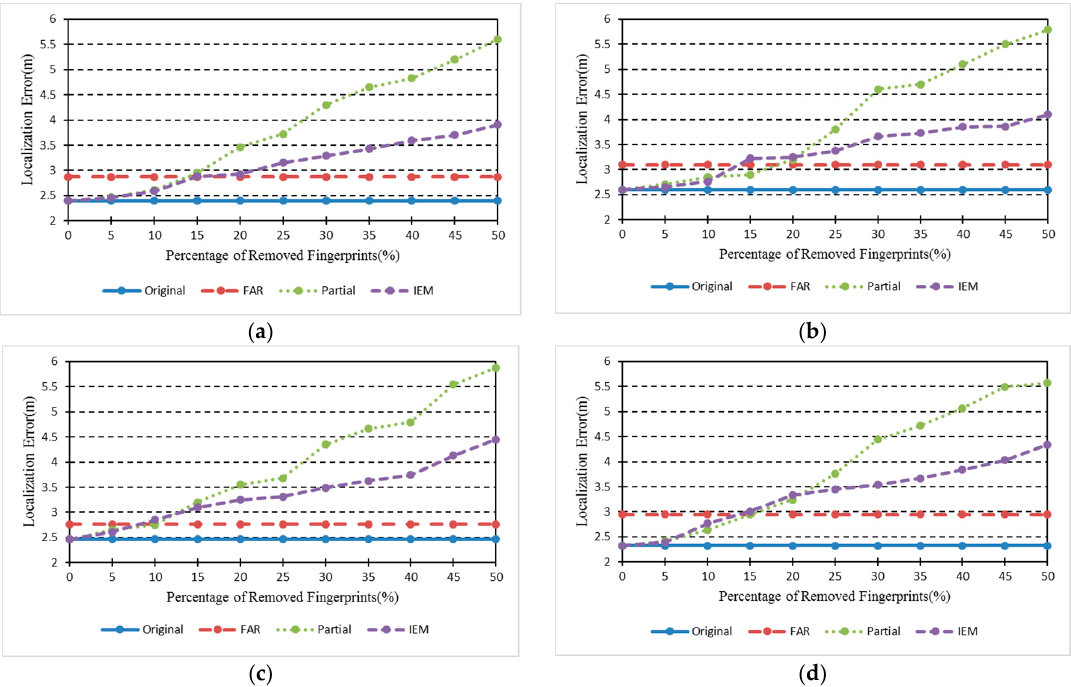
Figure 9. Localization results of four TPs. Original: The localization error obtained from Database_3; FAR: The localization error obtained from Database_4. Both of them are irrelative with Percentage of Removed Fingerprints. ( a ) TP1; ( b ) TP2; ( c ) TP3; ( d ) TP4.